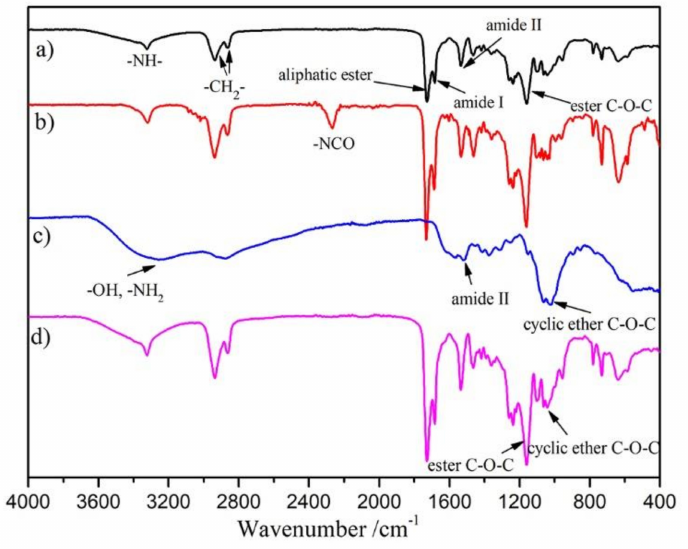
Figure 2. FT-IR spectra of ( a ) SPU, ( b ) SPU-NCO, ( c ) CHO (powder) and ( d ) SPU-CHO